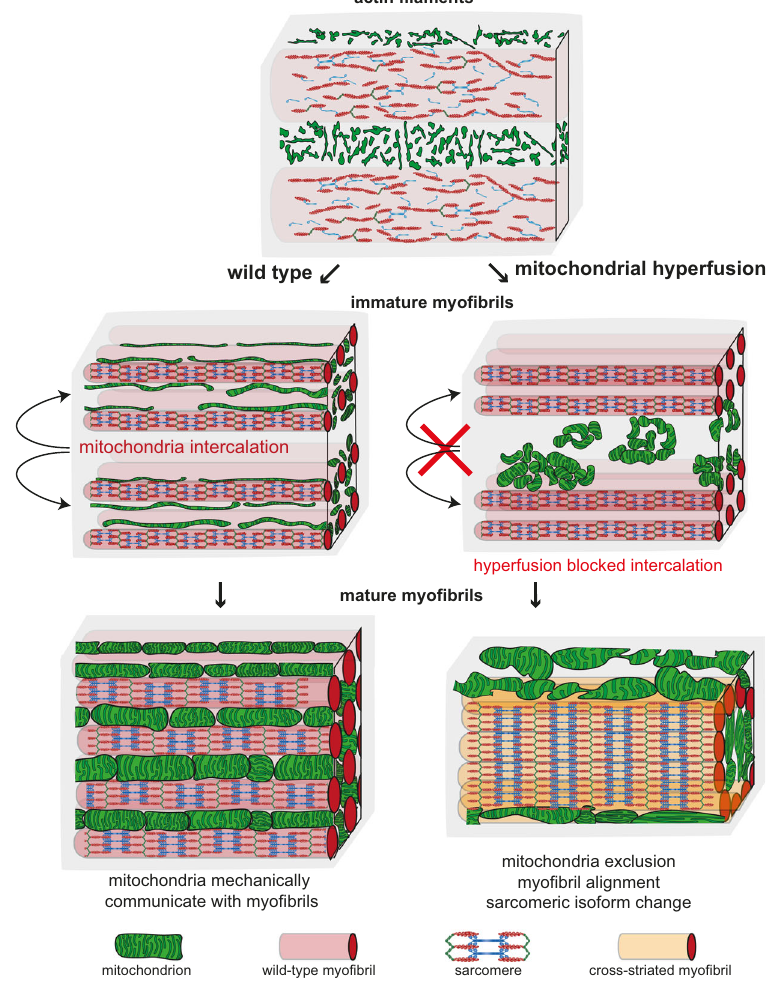
Fig. 9 Mitochondria – myo fi bril communication model. Developing fl ight muscle schemes to highlight the interplay between mitochondria with actin fi laments (top, early stage), immature myo fi brils (middle, intermediate stage) and mature myo fi brils (bottom, mature stage). Wild type is shown on the left and mitochondrial hyper-fusion on the right. At the actin fi lament stage, mitochondria display a fi lamentous network morphology spatially separated from the actin fi lament mesh. Upon myo fi bril assembly, mitochondria intercalate between myo fi brils in wild type and establish a tight mechanical communication. Myo fi bril and mitochondrial diameter growth causes generation of mechanical pressure and isolates individual myo fi brils. Mechanical feedback ensures the correct myo fi bril diameter. In contrast, hyper-fusion of mitochondria results in larger clustered mitochondrial networks that fail to intercalate between the immature myo fi brils. As a consequence of mitochondrial exclusion, the mechanical communication between mitochondria and myo fi brils is limited and myo fi brils align with each other around centrally clustered mitochondria. Scheme for sarcomeric components was adapted from Lemke and Schnorrer 3